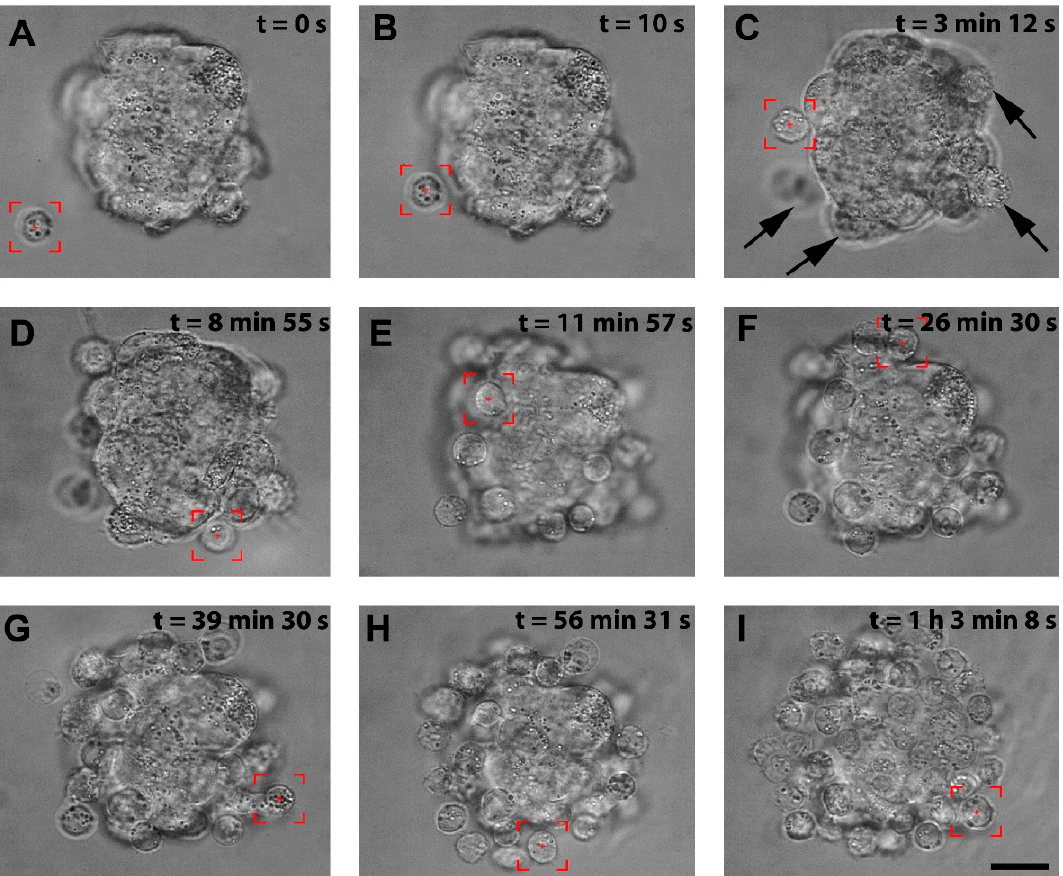
Figure 2. The visualization of the stages of the hybrid spheroid formation using OT. ( A ) A lymphoma cell is trapped by optical tweezers (highlighted by the red box). ( B ) the lymphoma cell is moved toward the surface of the stromal spheroid, and cell–spheroid contact is initiated. The lymphoma cell is retained in the center of the optical trap until an adhesion junction is formed between the lymphoma cell and the stromal spheroid. ( C ) Successive cells (indicated by arrows) are attached to the mass of the stromal spheroid. ( D – H ) The process of attaching subsequent lymphoma cells to the spheroid. ( I ) A complete hybrid lymphoma–stromal cell spheroid. Images were taken in the brightfield; scale bar = 25 µ